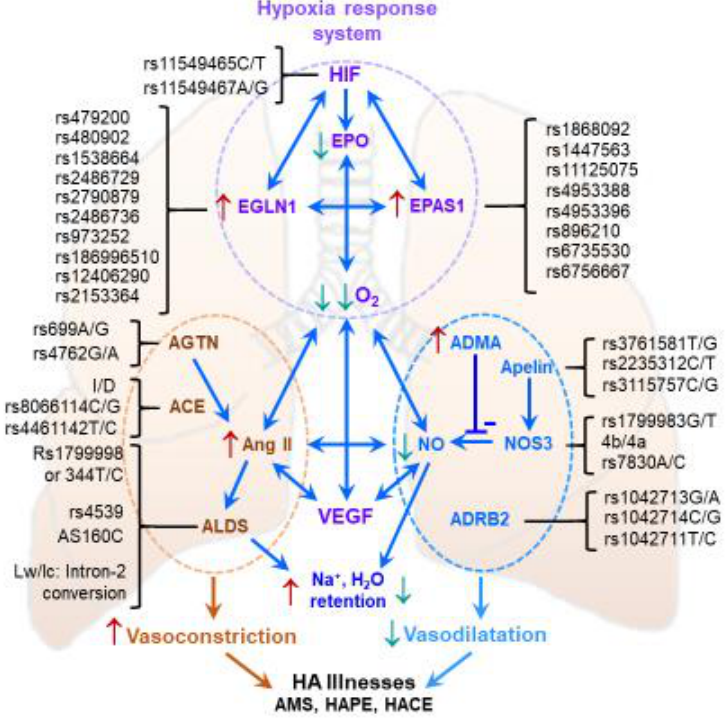
Figure 4. Genetic influence of the two major pathways on the physiological function.